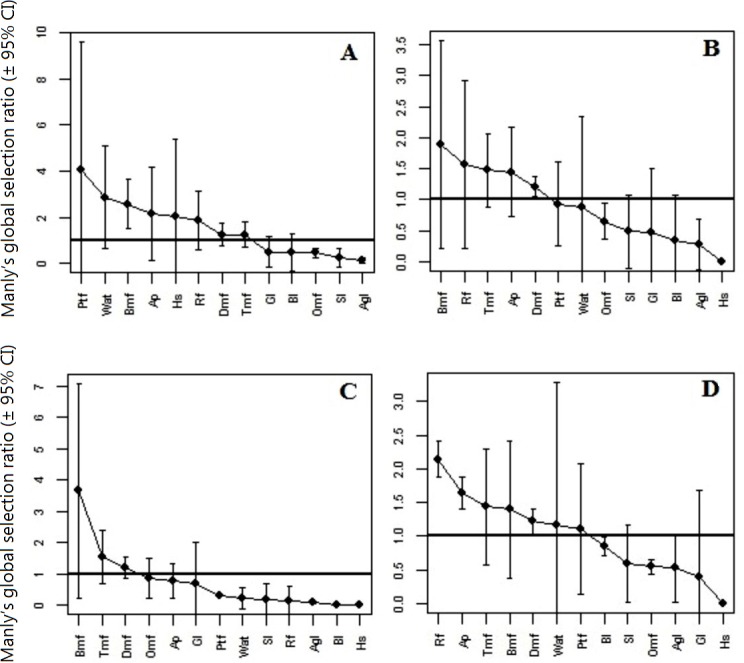
Manly’s selection ratio.Manly’s selection ratio of different land cover classes in Panna Tiger Reserve, Madhya Pradesh, India. ((A) Habitat preference of tigers during the exploratory period; (B) Habitat preference of tigers during the settled period; (C) Habitat preference of male tigers during the settled period and (D): Habitat preference of female tigers during the settled period.) (A–D) represent Global Manly’s Selection ratio with ±95% confidence intervals (CI) of the habitat types analysed in each category. Black dots (•) represent the mean selectivity rate of each habitat type. A habitat type can be considered as avoided if the global selection ratio is located in the 0–1 interval, while it can be considered positively selected if the value is larger than 1. Note differences in ordinate scale among (A–D). (Refer to Table 1 for a detailed descriptions of habitat variable abbreviations).